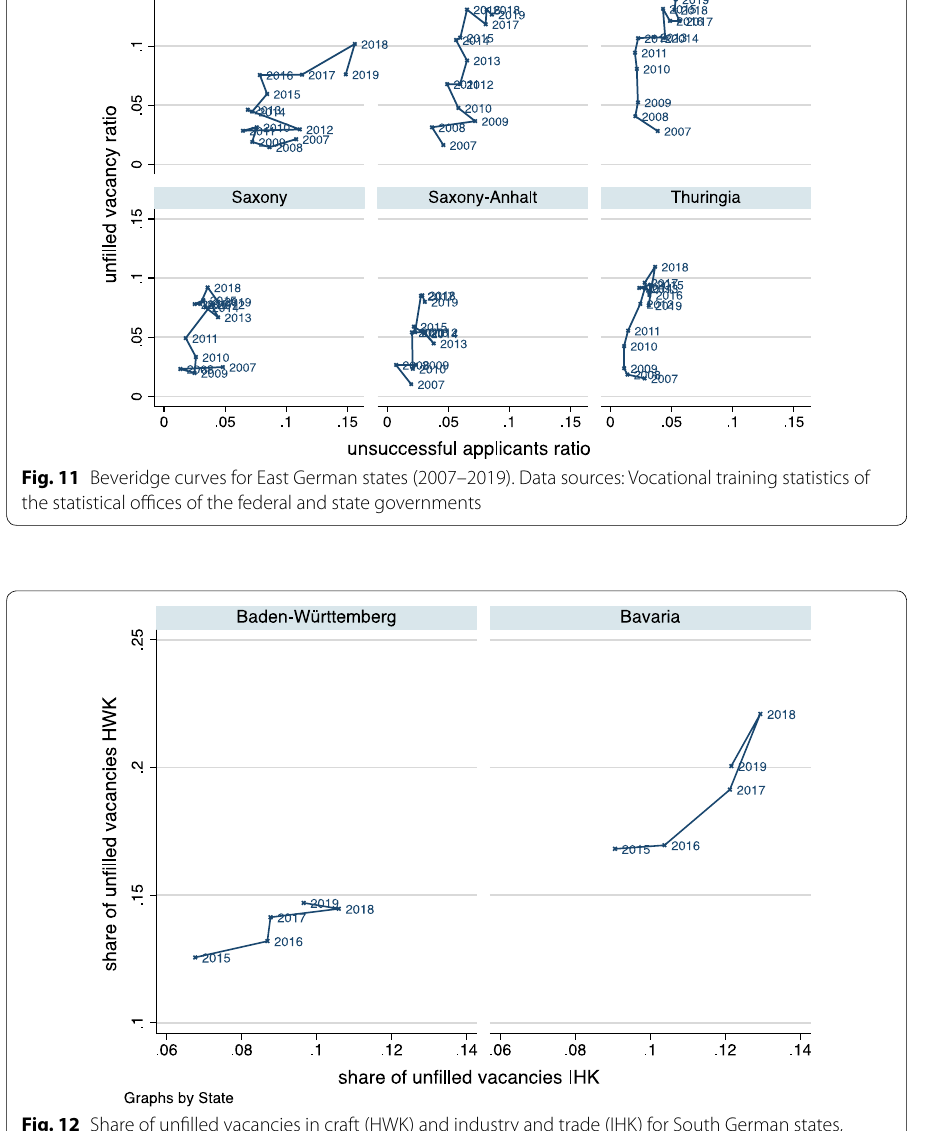
Fig. 12 Share of unfilled vacancies in craft (HWK) and industry and trade (IHK) for South German states, 2015–2019. Data sources: Vocational training statistics of the statistical offices of the federal and state